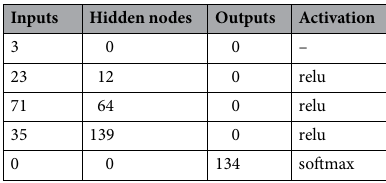
Table 7. C. elegans LeNet